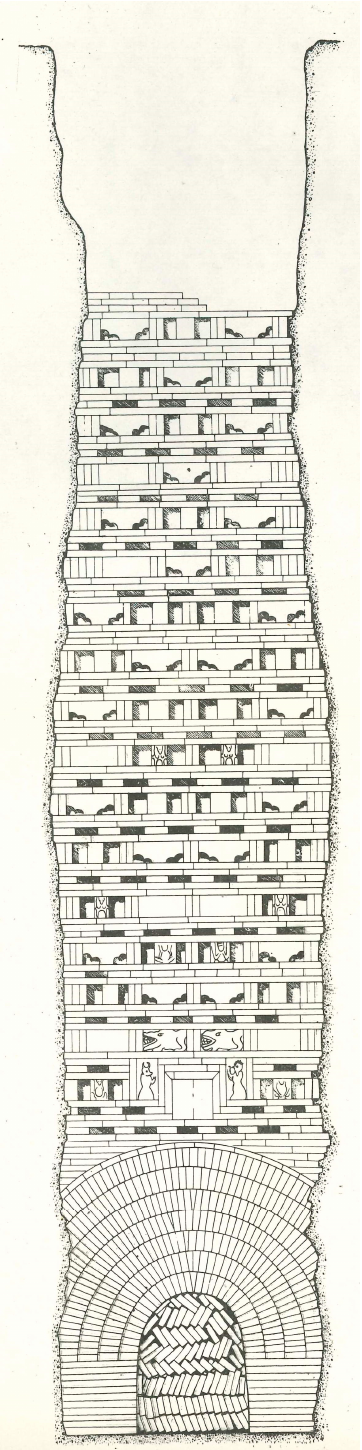
Figure 10. Screen wall Xincheng M7, carved and painted brick, Wei-Jin period (220–317). (Gansusheng Bowuguan et al. 1985, Figure 10). ©Wenwu Press. This figure published with permission of Wenwu Press and cannot be used or copied without their